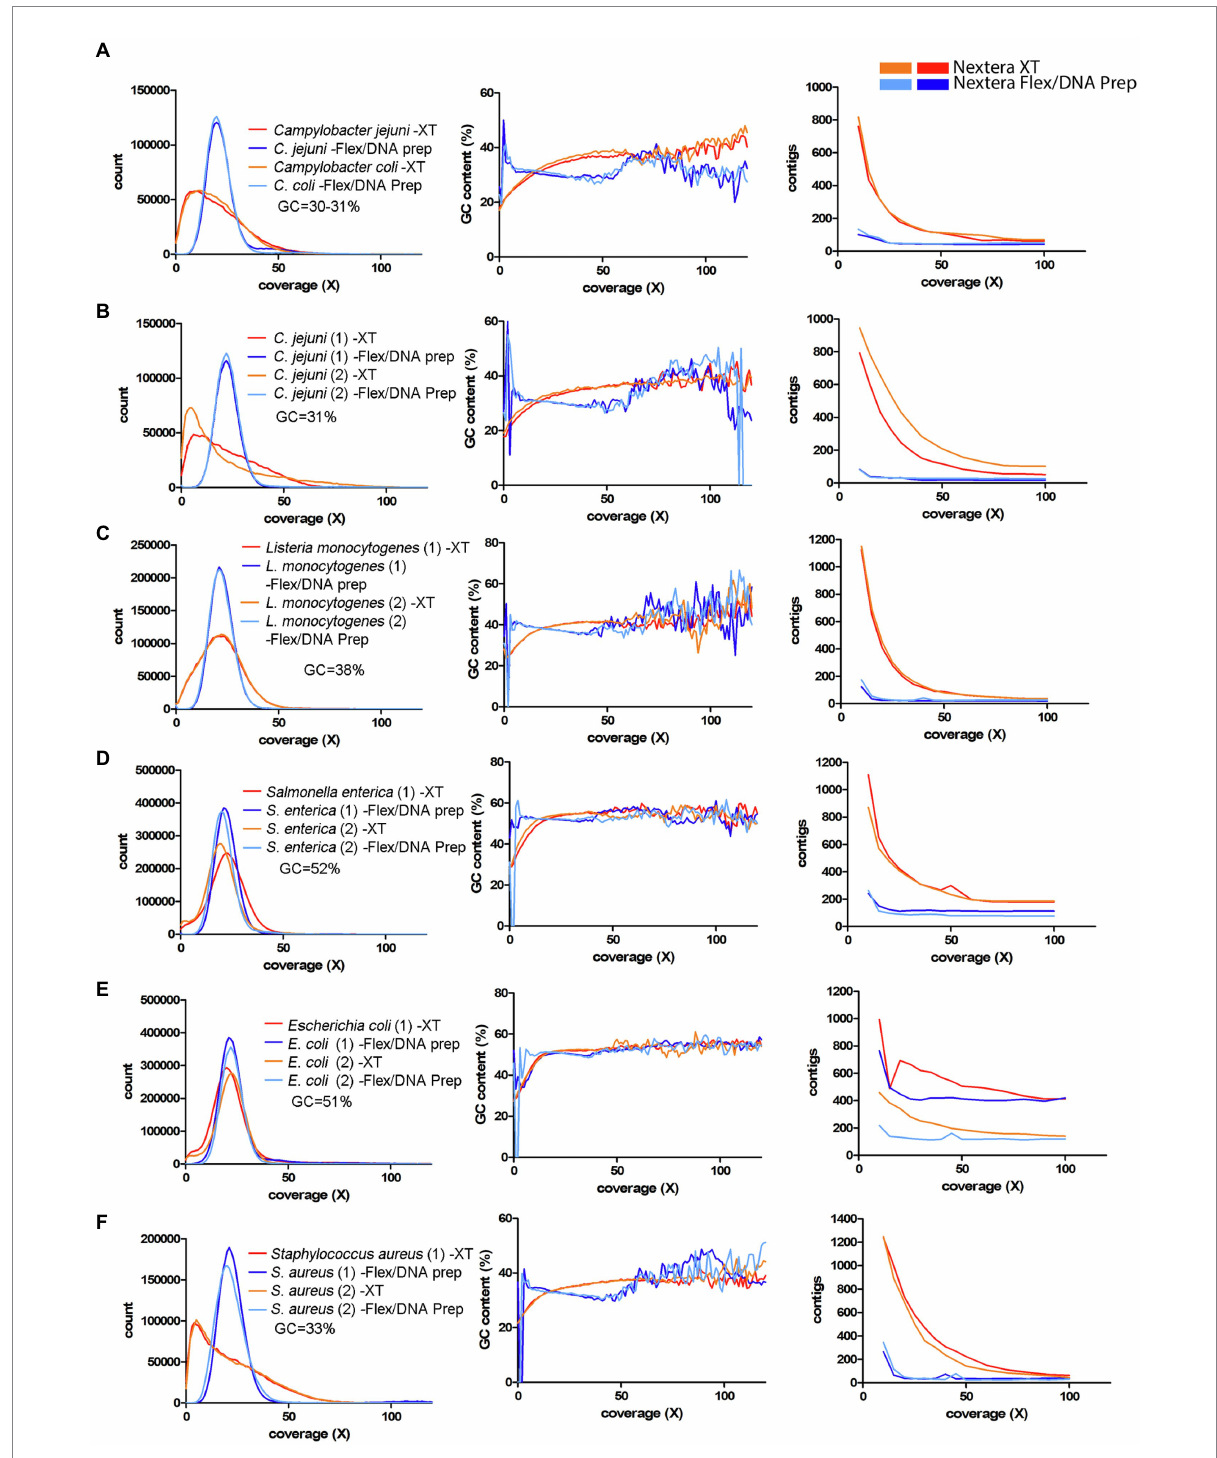
FIGURE 6 Coverage bias, connection to GC-content, and consequences on assembly efficiency for data produced with Nextera XT and Nextera Flex/DNA Prep in external datasets. The data have been colored to indicate the type of library prep kit used (Nextera XT orange/red, Nextera Flex/DNA Prep light blue/dark blue). Left column represents histograms over the depth in the raw data (downsampled to 50x) of the k -mers present in the reference sequence. Middle column represents the corresponding average GC-content of the k -mers in each histogram bin. The right column represents the number of contigs generated by SPAdes assembler after filtering short and low coverage contigs. (A) EURL- Campylobacter PT 28 data including Campylobacter jejuni and C. coli . (B–D) Data from an interlaboratory comparison made by BfR, Germany (Uelze et al., 2020a). Two strains each, of C. jejuni , L. monocytogenes, and Salmonella enterica . (E,F) Data from a study by Sato et al. (2019). Two strains each, of Escherichia coli and Staphylococcus aureus